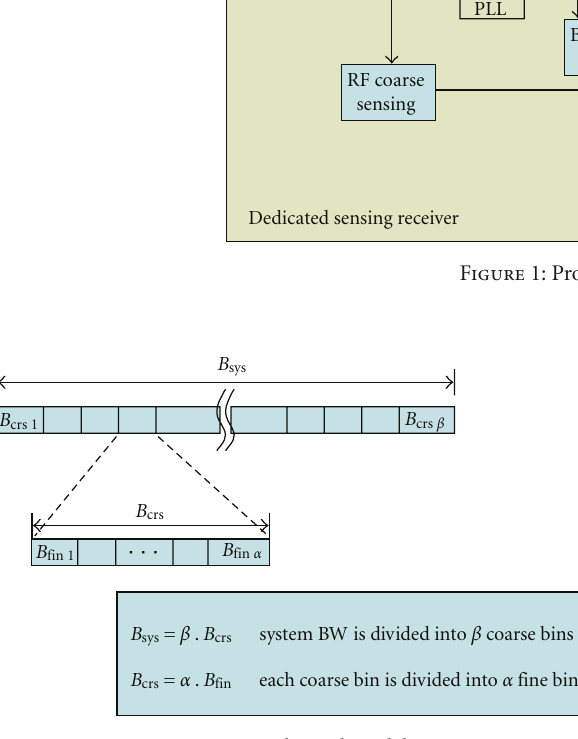
Figure 2: Channel